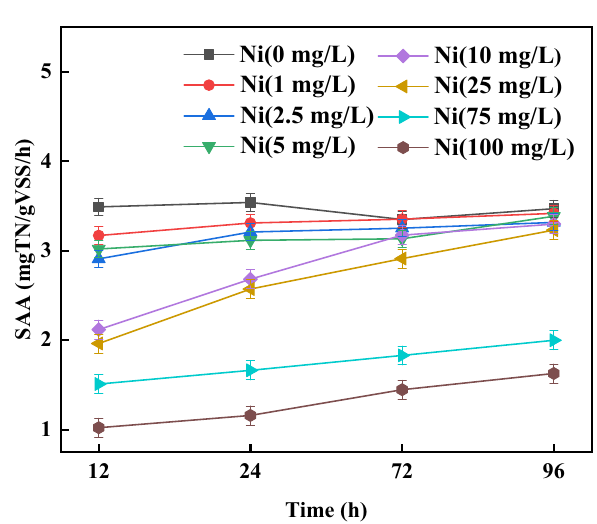
Figure 7. The activity recovery of anammox sludge with different Ni(II)